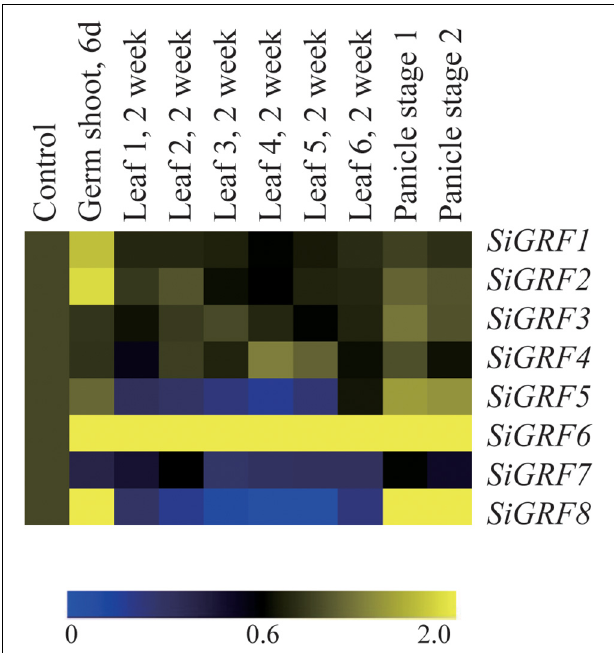
FIGURE 2 | Tissue-specific expression of foxtail millet SiGRF genes in four major tissues: shoot (control), germ shoot, leaf, and panicle (two stages). The color scale representing the log of signal values is shown below the expression profiles.